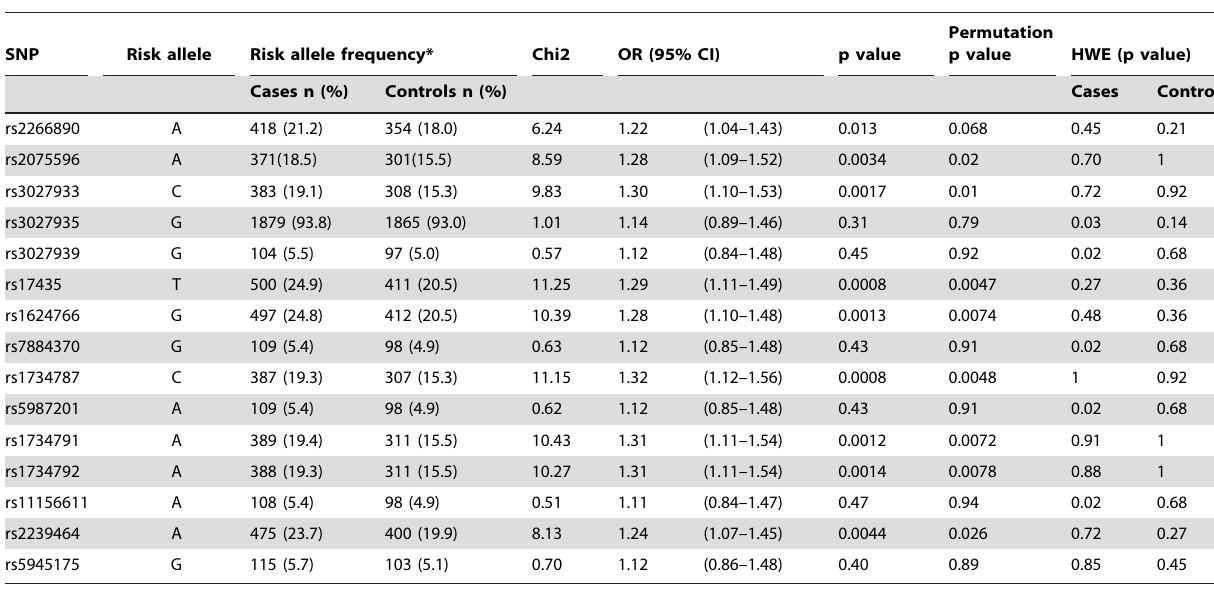
Table 5. Allele frequencies of MECP2 SNPs in European-derived SLE patients and controls